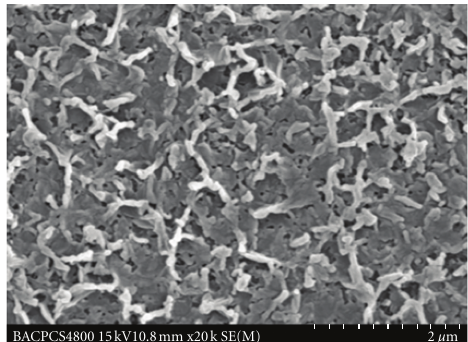
Figure 5: SEM image of ZnO tetrapods/TiO 2 photoanode fabri- cated via electrophoretic